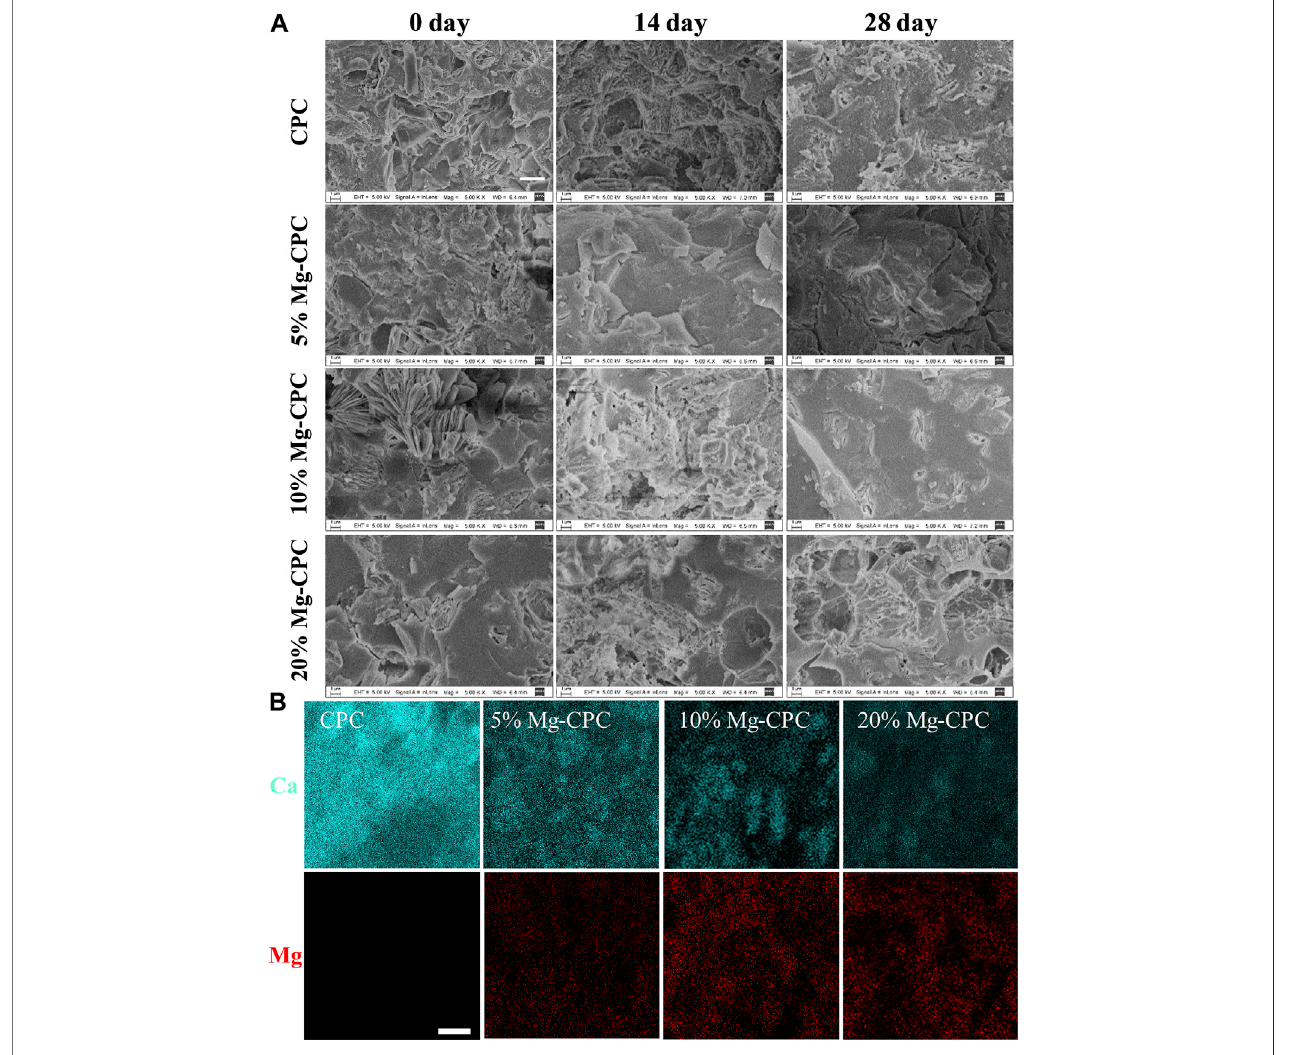
FIGURE1| SurfacemorphologyofCPCandMg-CPCssamplesbySEM. (A) TheSEMimagesofCPCandMg-CPCssamplesafterimmersioninSBF(Scalebar (cid:2) 3 μ m). (B) EDS mapping of Ca (blue dots), Mg (red dots); EDS analysis elements ’ composition on cement surfaces after immersion in SBF (Scale bar (cid:2) 10 μ m).